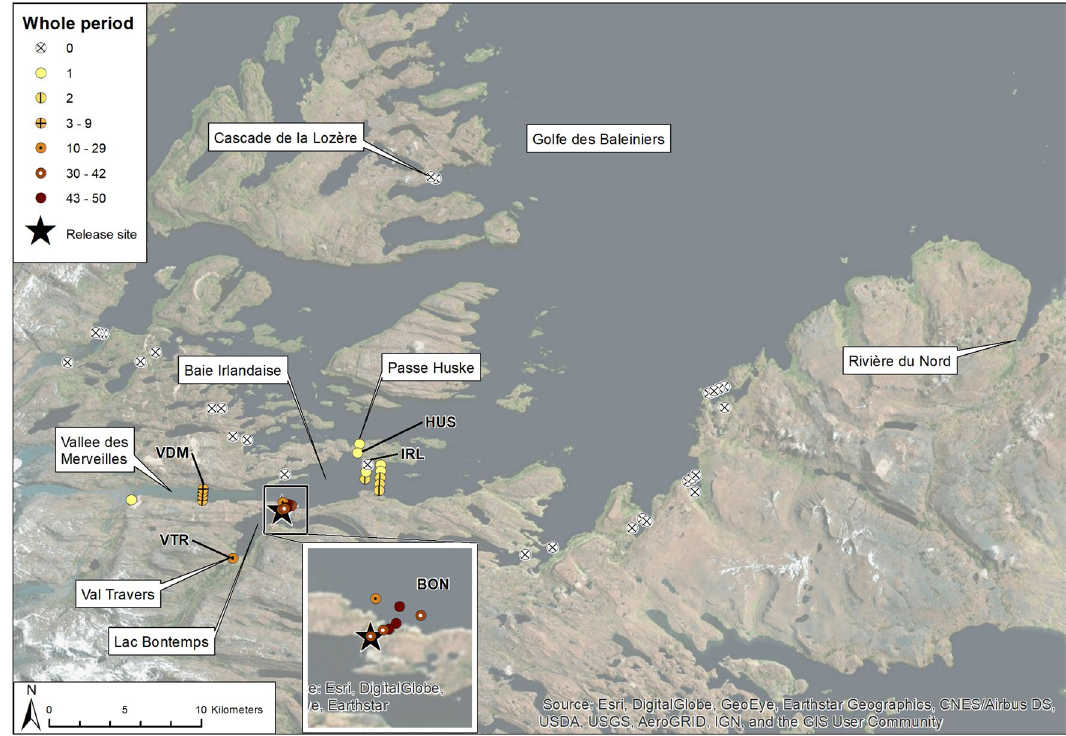
Figure 2. Map of the acoustic receiver array deployed ( n = 50 receivers). Symbols give the location of individual receivers and number of individual sea trout registered at each receiver. The tagging site (large star) was located next to the outlet of Lake Lac Bontemps. The map was powered by ArcGIS 10.5 (https:// suppo rt. esri. com/ en/ produ cts/ deskt op/ arcgis- deskt op/ arcmap/ angling fight times and by monitoring the gill net continuously (e.g., the net was pulled in as soon as vibrations were seen or felt). Shortly after landing and prior to anaesthesia, ~ 2 mL blood samples were collected via caudal venipuncture from all fish using literature protocols 39 . The mean time to blood sampling, as calculated from the time of hooking, was 4 min 17 s (range 02:31–07:20). Following blood sampling, fish were kept for no more than 6 h in a net cage situated in the river to allow recovery from capture and sampling prior to tagging. For tagging, the fish were anaesthetized with 2-phenoxyethanol (EC No. 204-589-7; SIGMA Chemical Co., USA; 0.5 mL L −1 water). An acoustic transmitter (Thelma Biotel, model CT-MP9L, 9.0 × 42.5 mm, mass in water 4.2 g, power output 146 re 1 μPa at 1 m, estimated minimum tag duration 300 days) was externally attached to the fish below the dorsal fin with 0.5 mm steel wires inserted horizontally through the upper part of the dorsal muscu- lature. The wires were threaded by using two hollow needles (1.25 mm in diameter), sharpened at one end. The needles were pushed through the musculature approximately 20 mm below the dorsal fin. The spacing between the needles matched the length of the tag. To avoid erosion of the flesh by the tag or attachment wire, a silicone plate was attached between the tag and the skin, and a plastic plate was attached between the skin and the wire on the opposing dorsal side 40 . Throughout the tagging process, the gills were irrigated with fresh, ambient river water. For all fish a small part of the adipose fin was clipped and stored in alcohol for later genetics analysis of sex. After tagging, the fish were released in a calm part of the Bontemps estuary or near the shoreline close to the capture site. To measure levels of salinity and water temperature encountered by the individual fish, each acoustic tag was equipped with a sensor for conductivity (range 0–34‰, resolution 2‰) and temperature (range 0–15 °C, resolution 1 °C). The tags were programmed to sample every 45 s and the most recent values, along with the individual fish ID, were transmitted with a random 30–90 s interval delay. The care and use of field-sampled animals complied with the Government of France animal welfare laws, guidelines and policies (Comité d’Ethique) as approved by the Terres Australes et Antarctiques Françaises admin- istration under the auspices of permit number (Référence du dossier) 2016122009113932-v2. All methods are reported in accordance with ARRIVE guidelines.